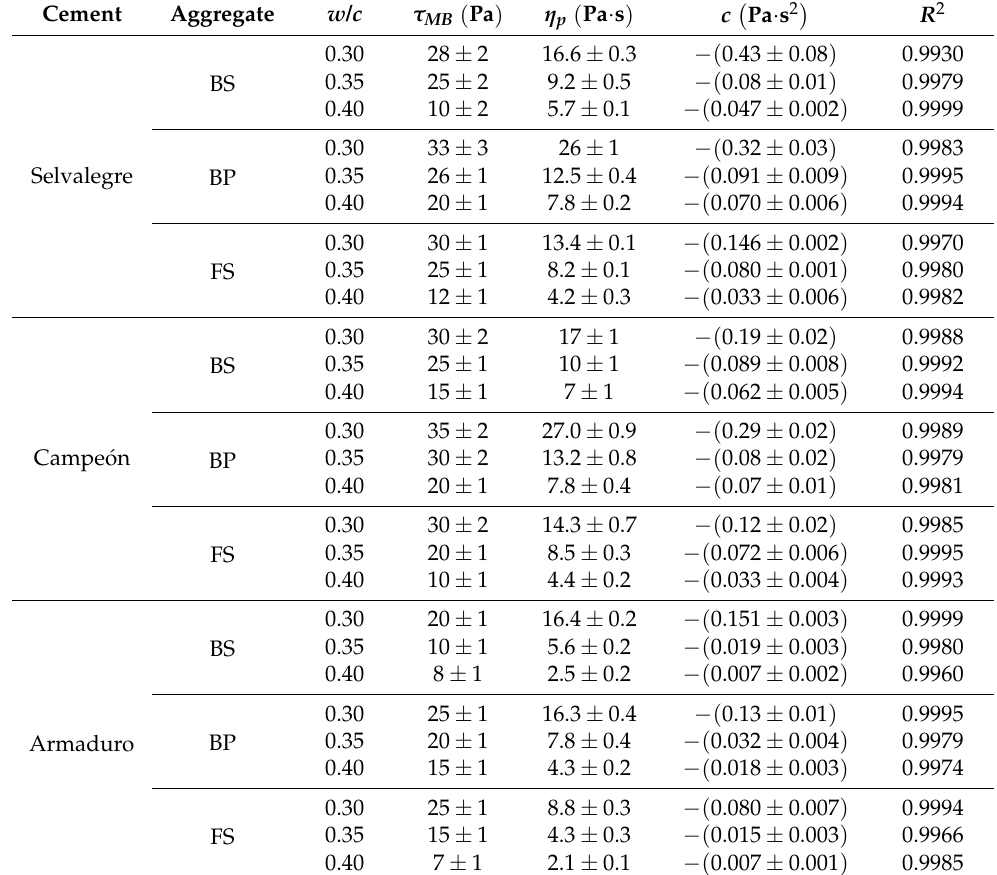
Table 8. Parameters of modified Bingham equation.